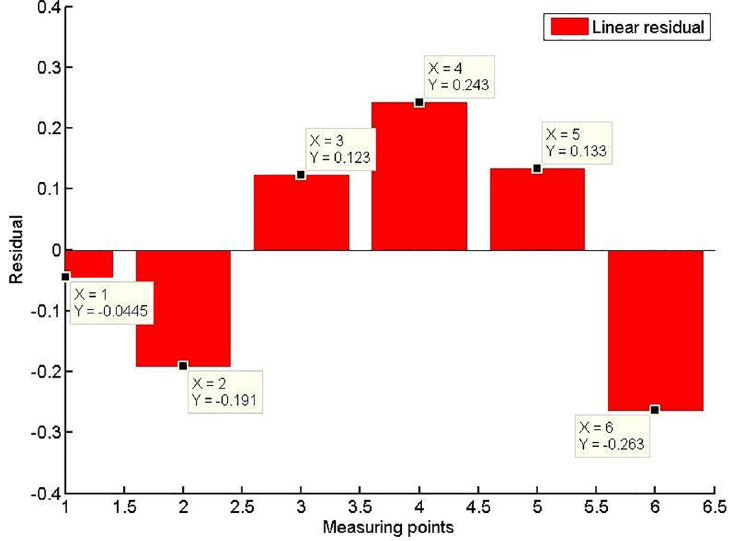
Fig 19. Fitting residuals at each measuring